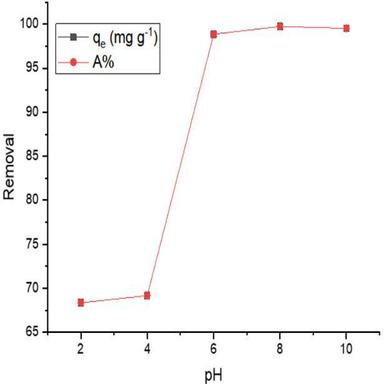
The plot of pseudo-first order kinetic.